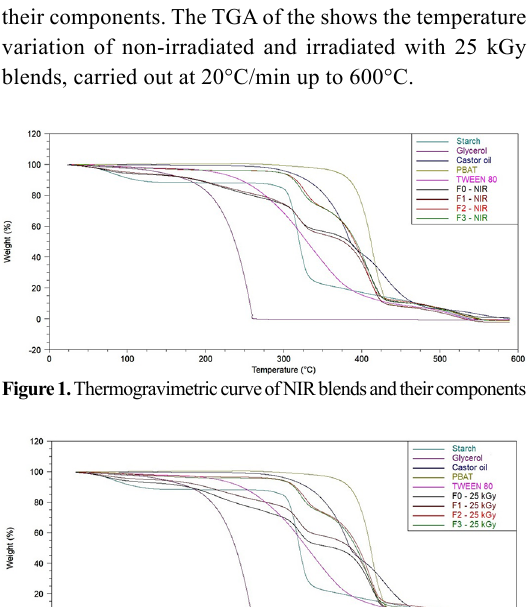
Table 1. Formulations of TPS/PBAT blends, and other components